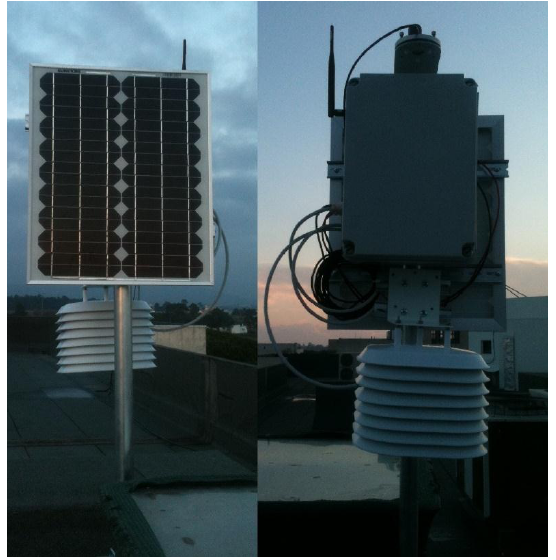
Figure 3. Two sides of the weather station prototype.